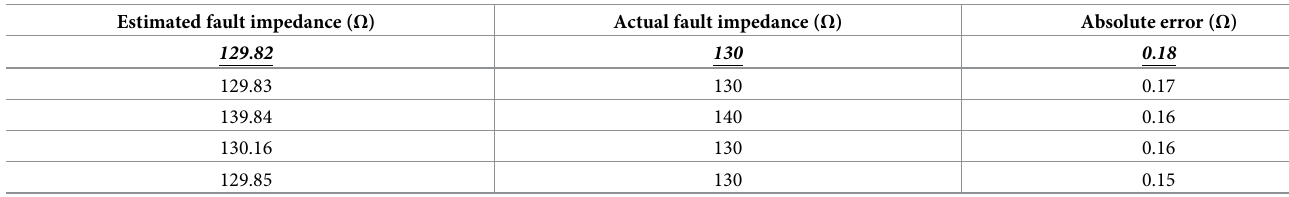
Table 14. Fault impedance estimation (ABCGF).